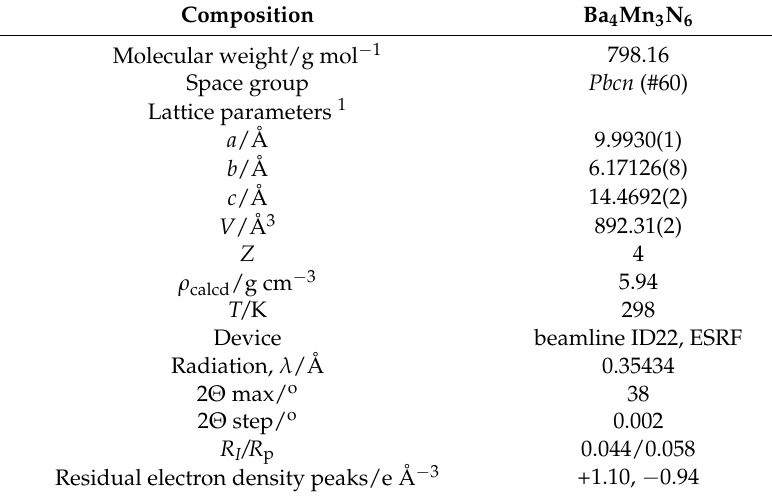
Figure 3. Coordination environment of ( a ) barium, ( b ) nitrogen, and ( c ) manganese atoms in Ba 4 [Mn 3 N 6 ]. Distances are given in Å. Table 1. Crystallographic Data and Experimental Details for Ba 4 [Mn 3 N 6 ] at 298 K.